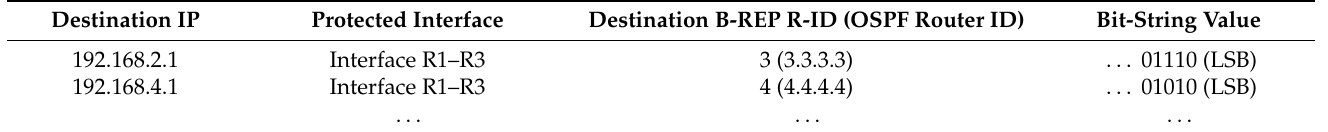
Table 3. B-REP Backup Table.